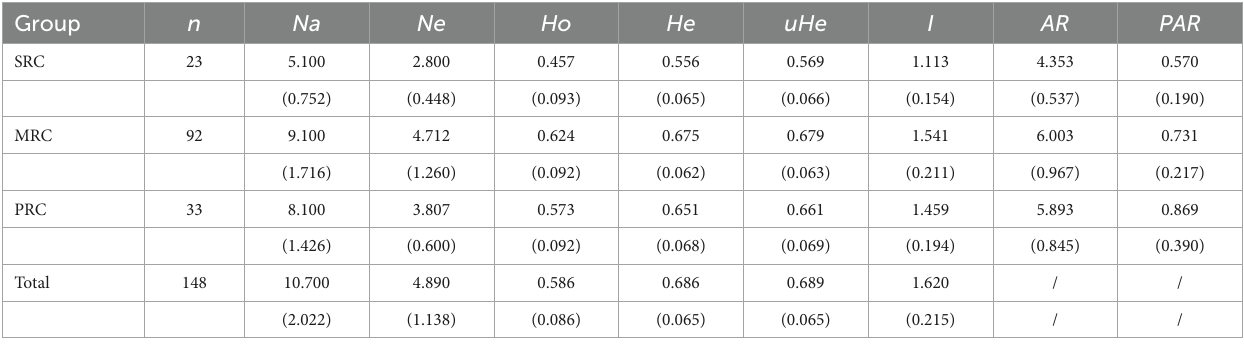
TABLE 1 Genetic diversity parameters within each of the phenotypic groups varying in cold resistance and the total population based on 10 nuclear microsatellite loci. Group